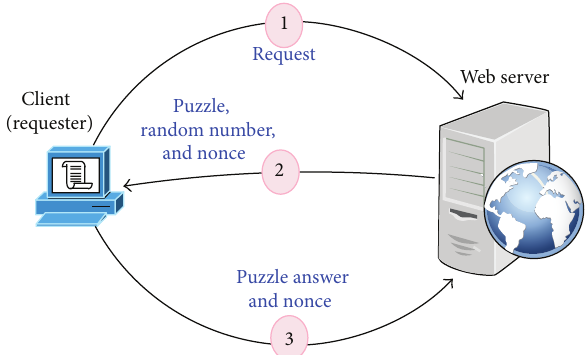
Figure 3: Conceptual steps of the STBOA web service puzzle for validating clients.